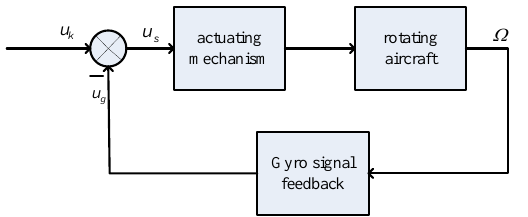
Figure 2. The block diagram of damping loop.